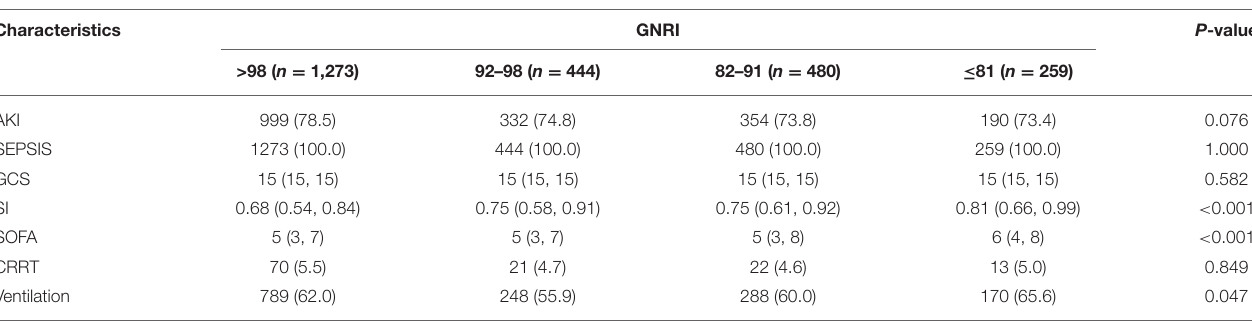
TABLE 4 | Comparison of important indicators among the four subgroups.